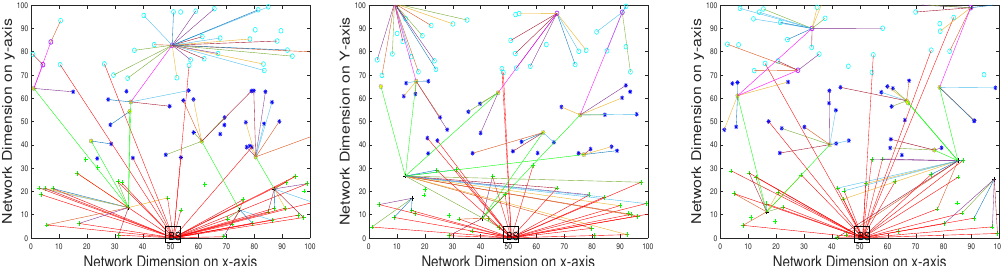
Figure 4. SADFIR routing mechanism and protocol.